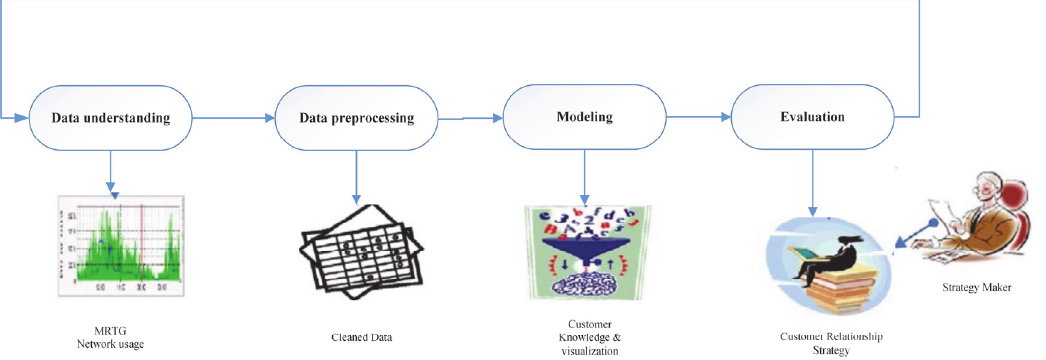
Fig. 2. Framework of tree